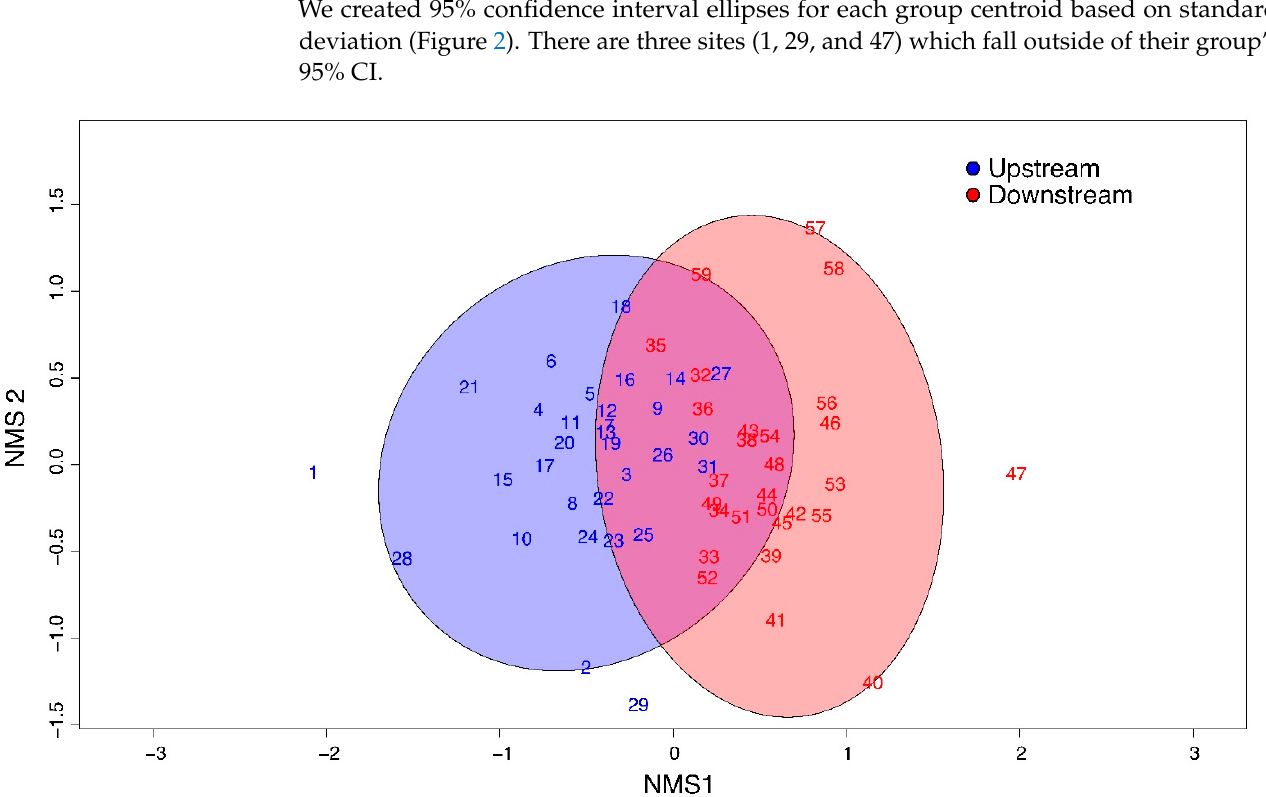
Figure 2. Non-metric multi-dimensional scaling (NMS) plot of mussel assemblages at 59 Strawberry River sampling sites. Ellipses represent 95% confidence intervals around group centroids for two geographic groupings representing upstream (blue) and downstream (red) assemblage groups. There are three sites (1, 29, and 47) which occur outside of the 95% confidence interval ellipses.